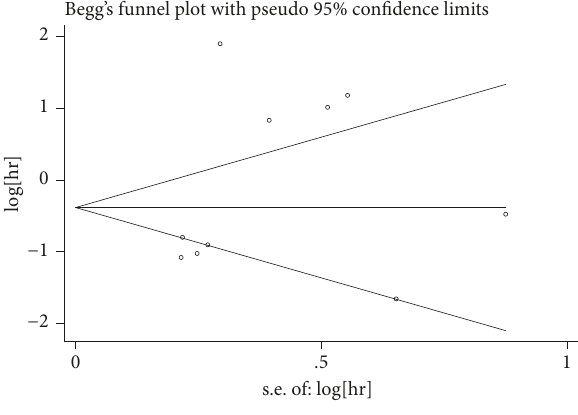
Figure 7: Begg’s funnel plots for all of the included studies reported with overall